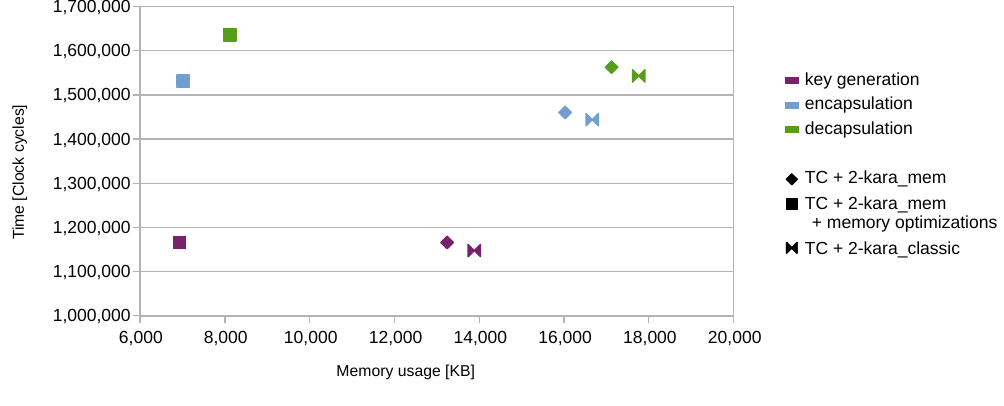
Figure 5: Time vs memory for different combinations of optimizations in Cortex-M4.